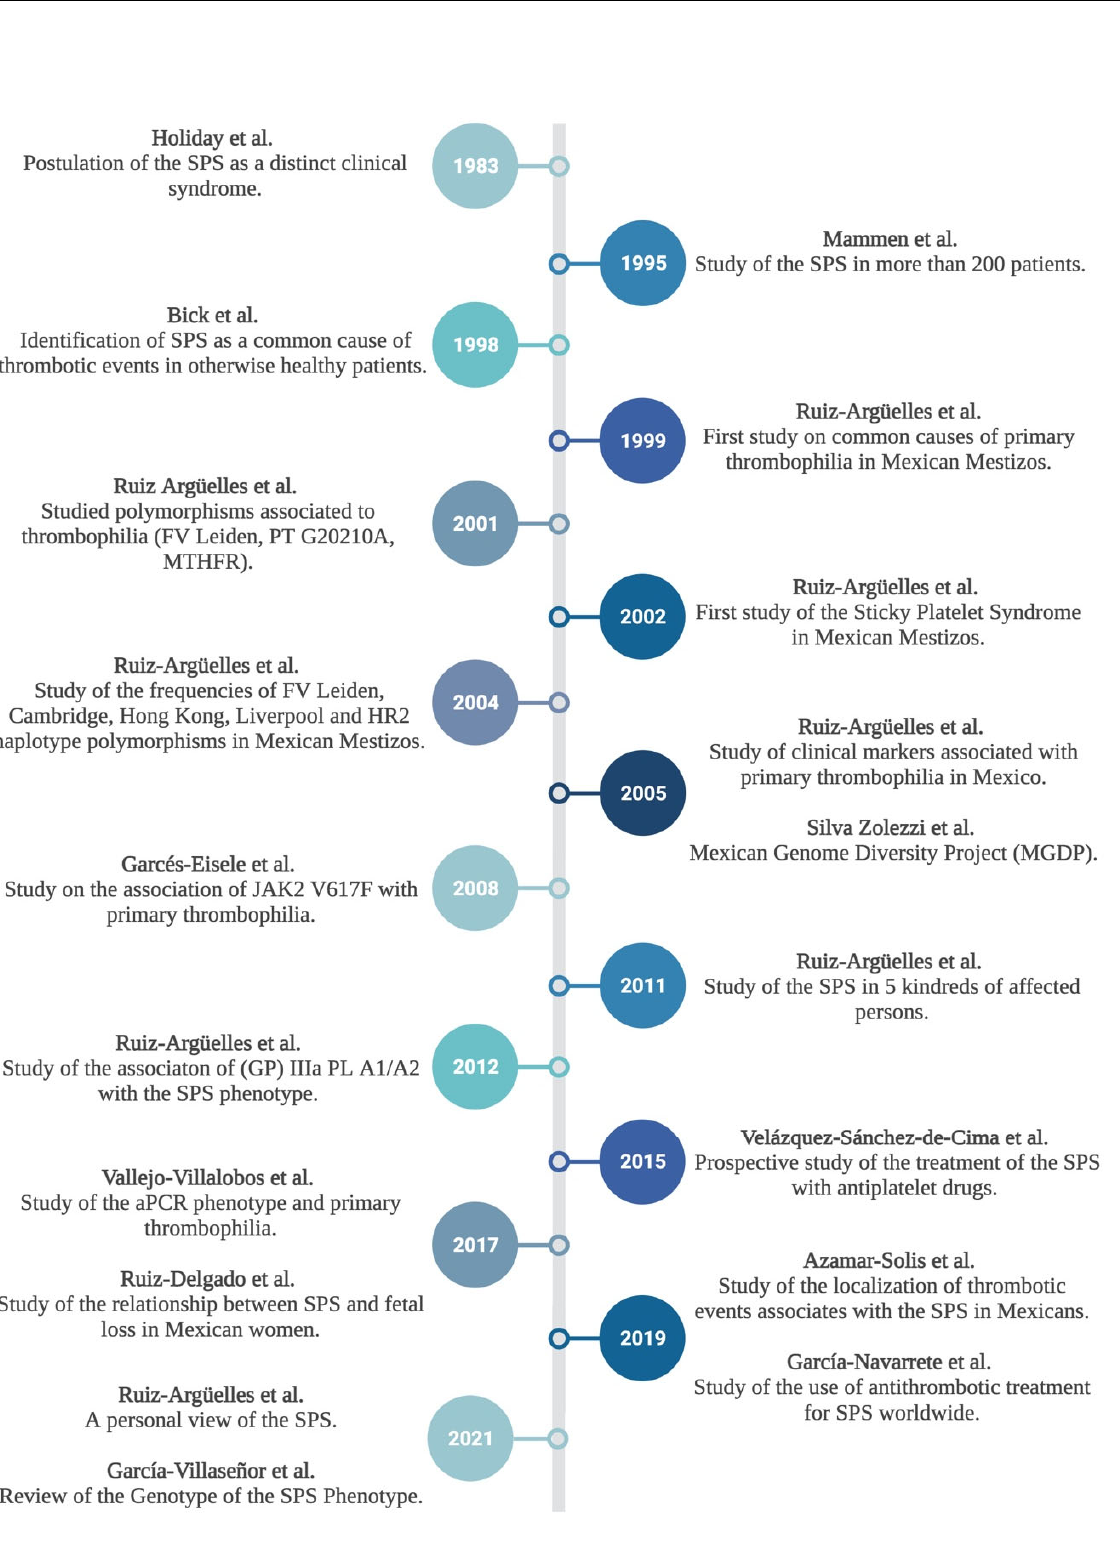
Figure 1. Timeline of the initial studies on Sticky Platelet Syndrome, and subsequent studies conducted and published in México. SPS: Sticky Platelet Syndrome. MTHFR: Methylenetetrahydrofolatereductase. (GP)IIIa PL A1/A2: Glycoprotein IIIa. aPCR: activated protein C resistance. Created in Biorender.com (accessed on 2 July 2022).